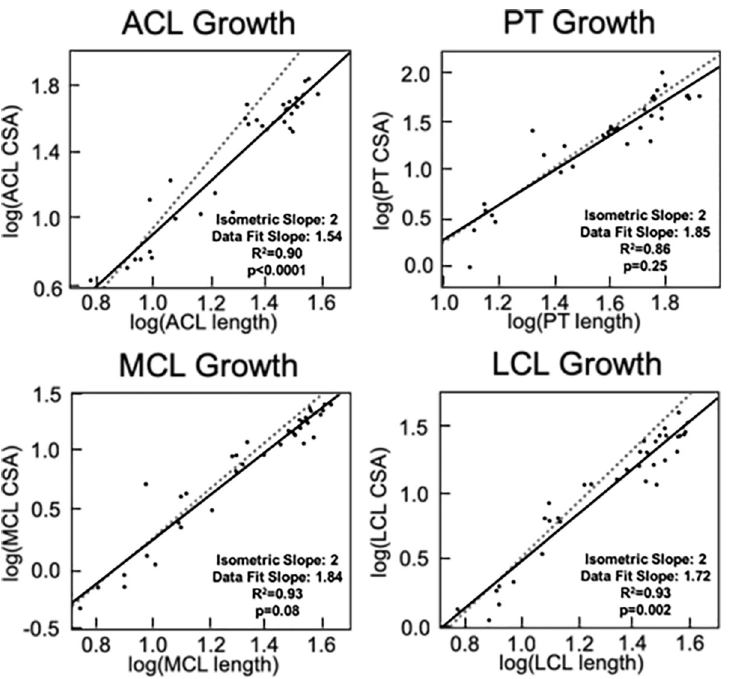
Fig 6. Assessment of allometric growth within each tissue. Comparisons of CSA and length for the ACL and LCL reveal allometric growth whereas the PT and MCL exhibit isometric growth. In these plots, the dashed line represents the line of isometry while the solid line represents the line of best fit for the data (R 2 values provided, p < 0.05 denote statistical difference from isometric line, slopes denote standard and best fit lines).